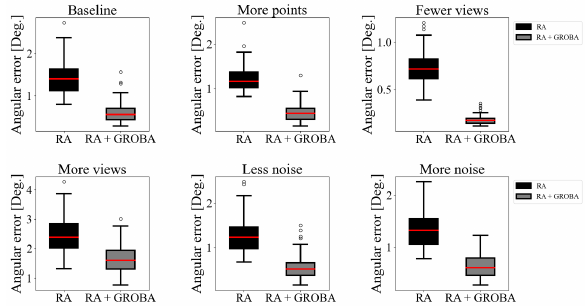
Figure 6: Results of the synthetic data test settings. Comparison between RA and G-ROBA (initialized by RA) in terms of the mean angular error after the L 1 alignment.